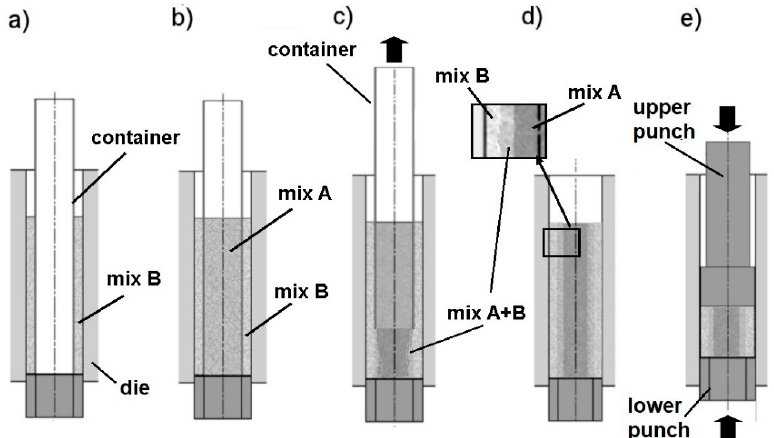
Figure 2. Successive stages of compact fabrication: ( a ) filling the outer layer; ( b ) filling the container, ( c ) and ( d ) removing the container; ( e ) double-sided pressing. Table 3. The designation of products and the applied technological parameters. CS: conventional sintering; SPS: spark plasma sintering method.